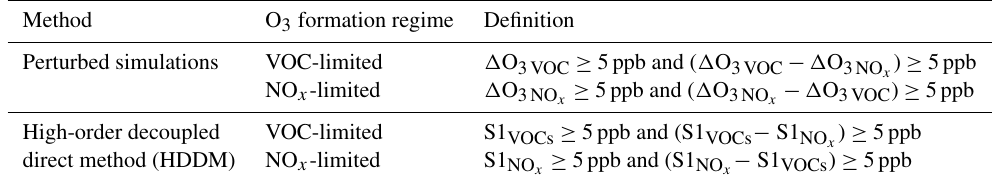
Table 1. Identification of the O 3 formation regimes at each grid cell based on the O 3 changes resulting from perturbed emissions as in Sillman et al. (1998) or the sensitivity coefficients using the high-order decoupled direct method (HDDM) as in Wang et al.